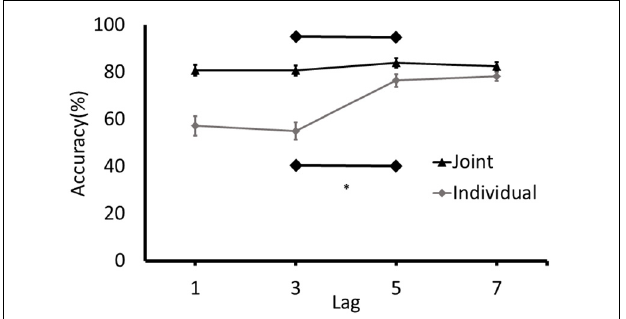
FIGURE 3 | Detection rates of T2 (% of correctly identified as a function of the targets presented) for Experiment 2. Error bars represent standard error of the mean. ∗ Denotes significance at p <